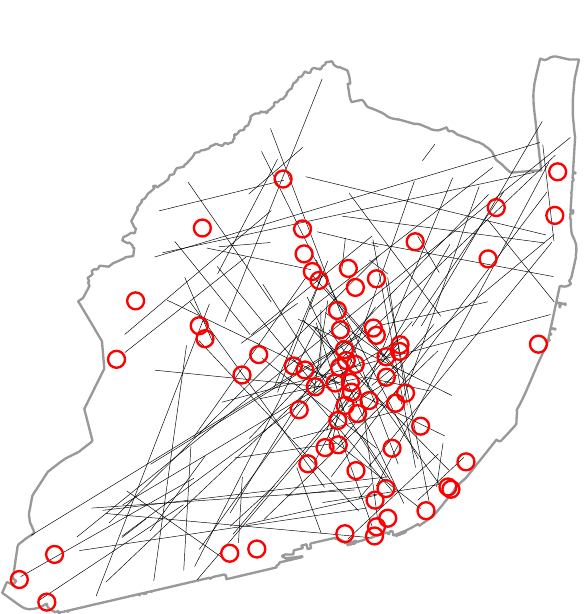
Figure 3. Trips represented with jittered desire lines, with no